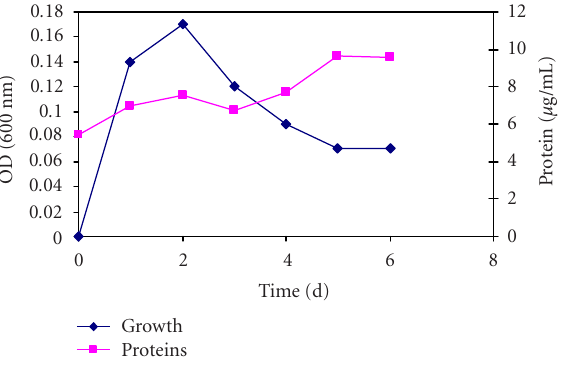
Figure 12. Protein production relative to growth of Pichia pastoris X-33 (mut + )